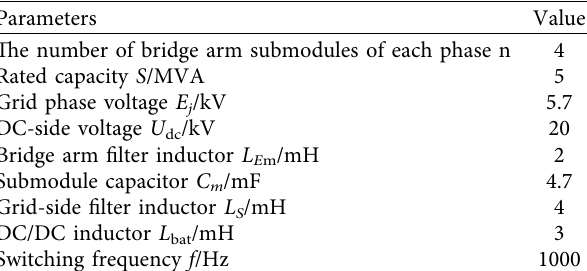
Figure 15: SOC equalization correction control of submodules in bridge arms. Table 2: System simulation